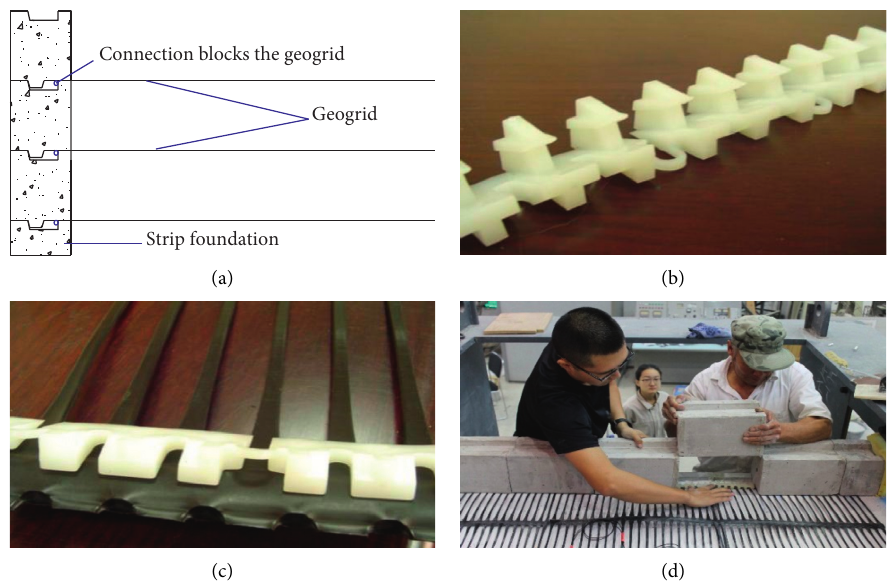
Figure 6: Connection between the geogrid and block: (a) schematic diagram, (b) plastic clasp, (c) geogrid and clasp, and (d) model